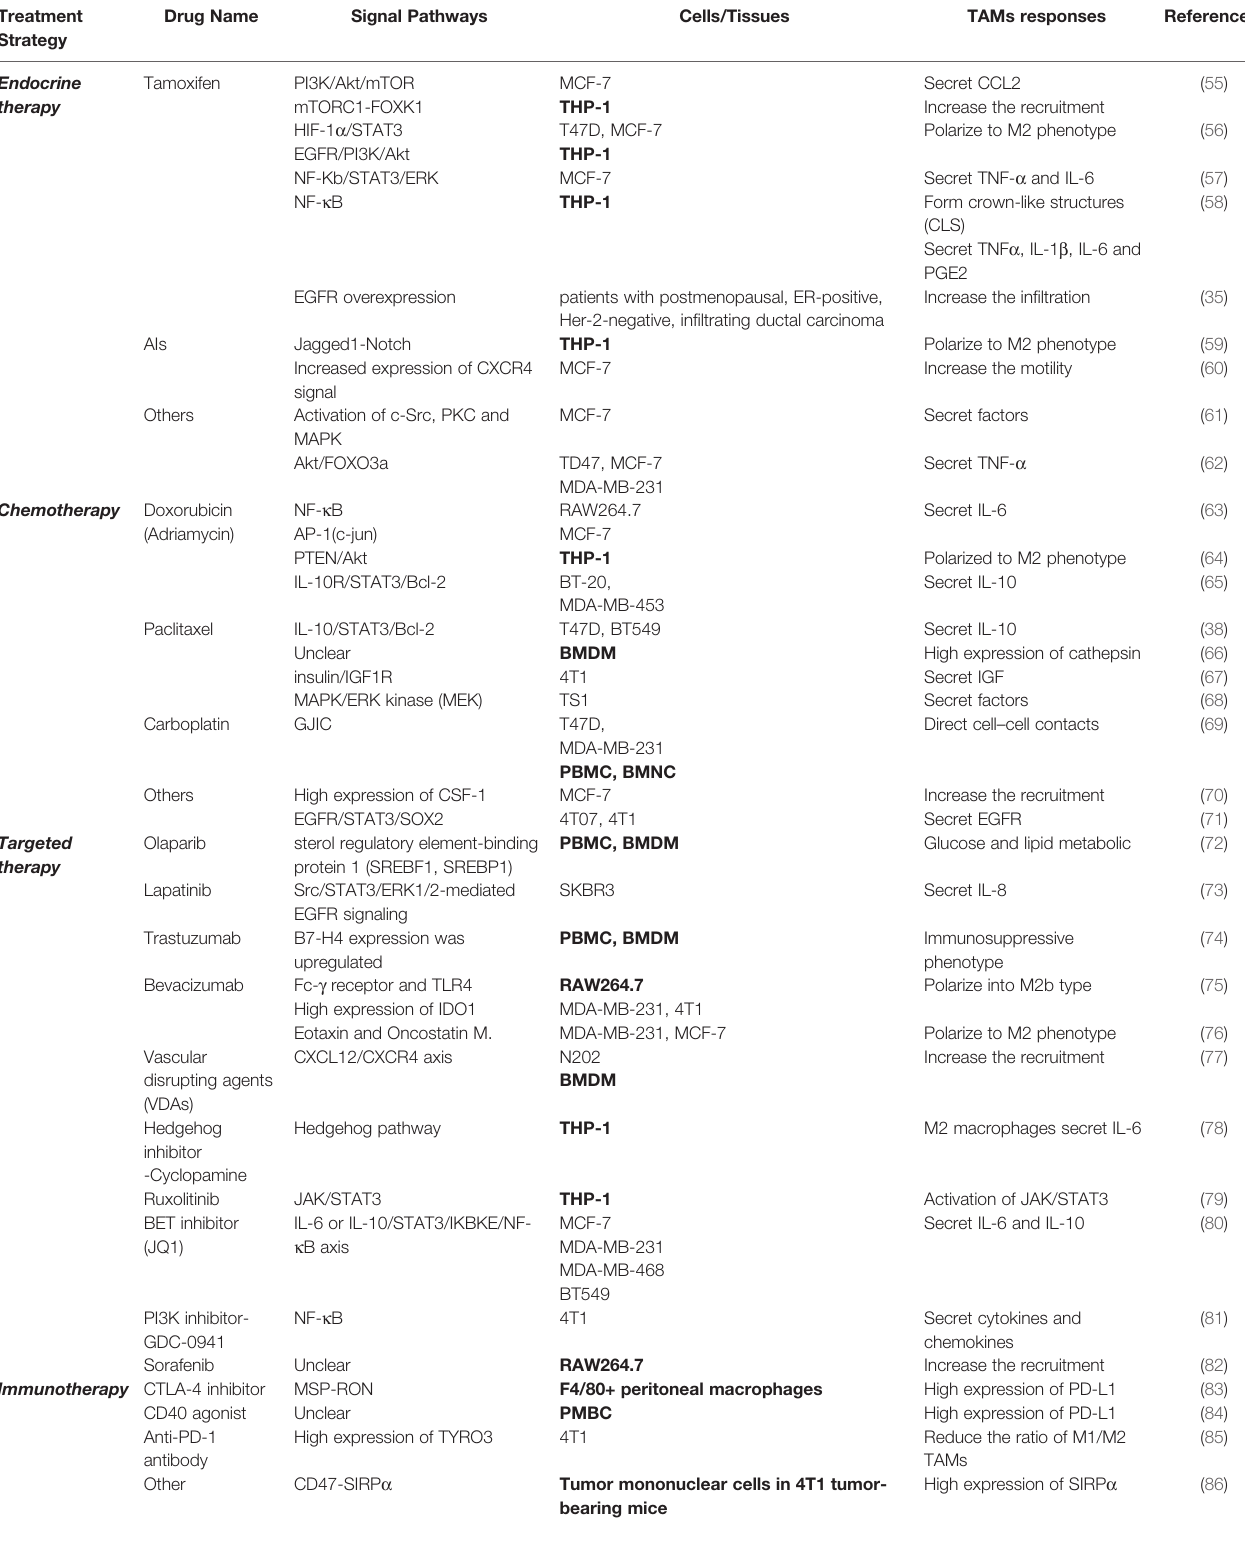
TABLE 1 | The molecular mechanism of TAM-mediated BC treatment resistance. Treatment